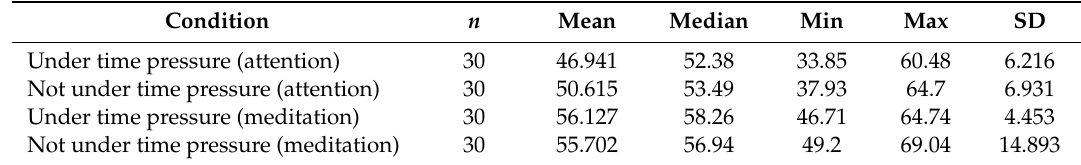
Table 6. Descriptive statistics for attention and meditation levels.